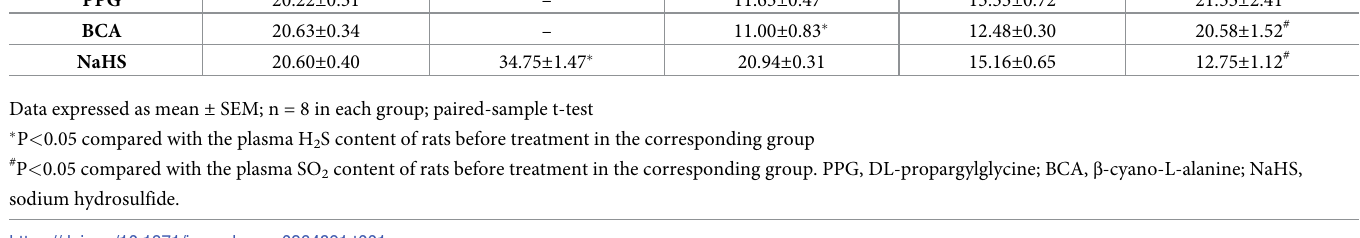
Table 1. Plasma contents of H 2 S and SO 2 in rats before and after treatment with PPG, BCA or NaHS. Groups H 2 S content ( μ mol/L)